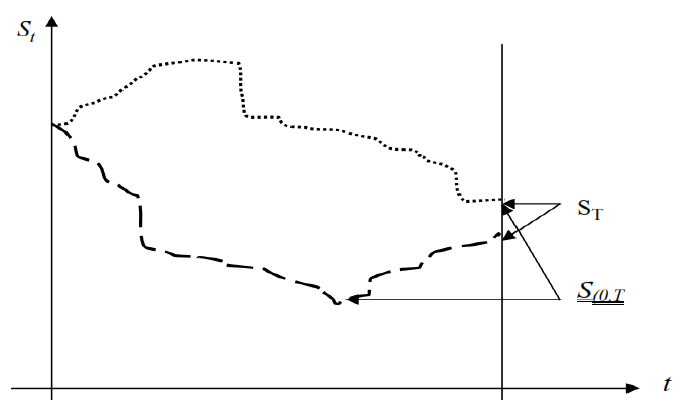
Figure 1. Path followed by the stock price over a period of time T . Source: MaxVaR: Long Horizon Value at Risk in a Mark-to-Market; Environment by Boudoukh et al. (2004).